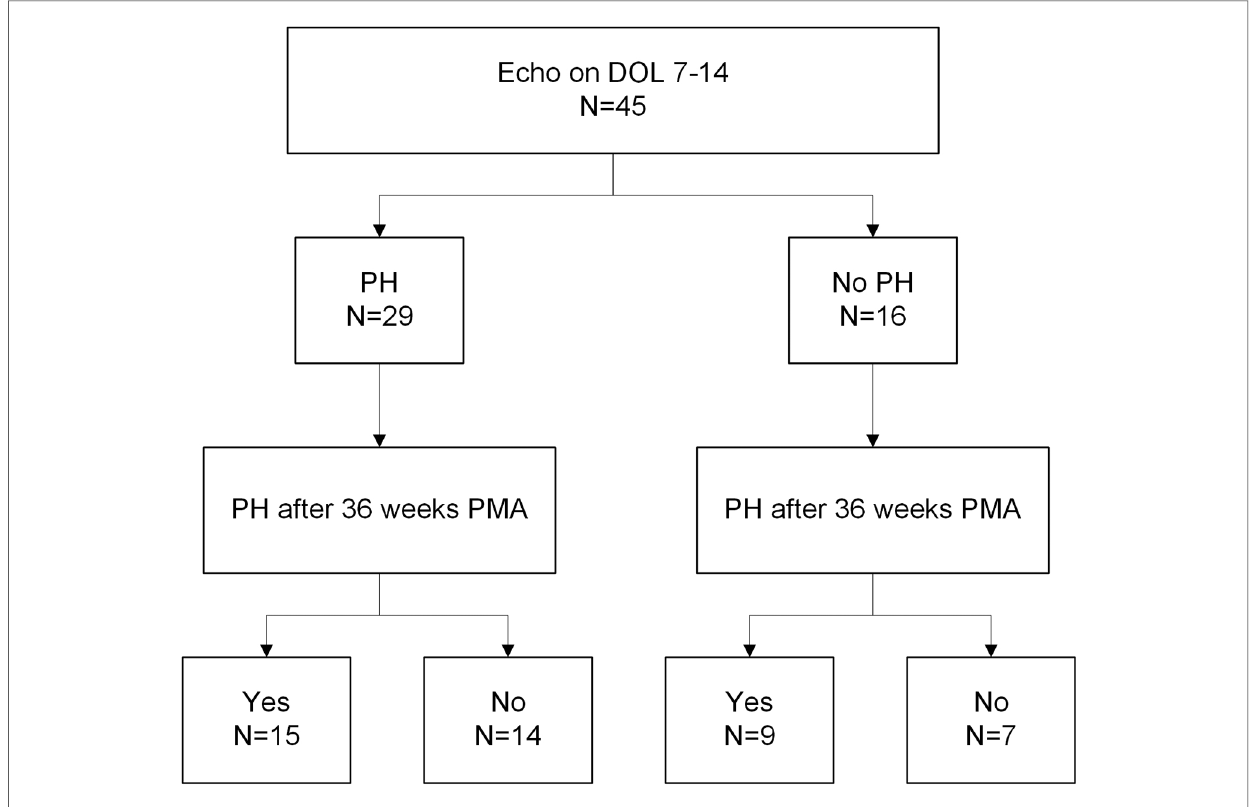
FIGURE 3 Flowchart of early echocardiogram PH diagnosis (DOL 7-14) and BPD-PH after 36 weeks PMA. Chi-squared test between groups has a p -value of 1. PH, pulmonary hypertension; BPD, bronchopulmonary dysplasia; DOL, day of life; PMA, postmenstrual